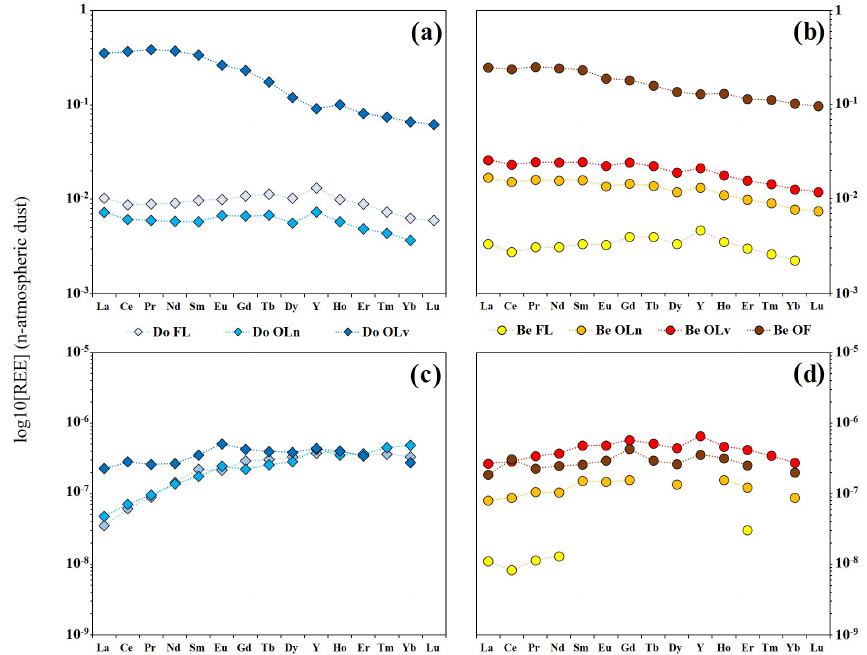
Figure 3. REE concentration patterns in samples of fresh leaves and litter of Douglas-fir (a) and beech (b) ; REE concentration patterns in leachates of fresh leaves and litter of Douglas-fir (c) and beech (d) . REE concentrations were normalized by the values in the local atmospheric